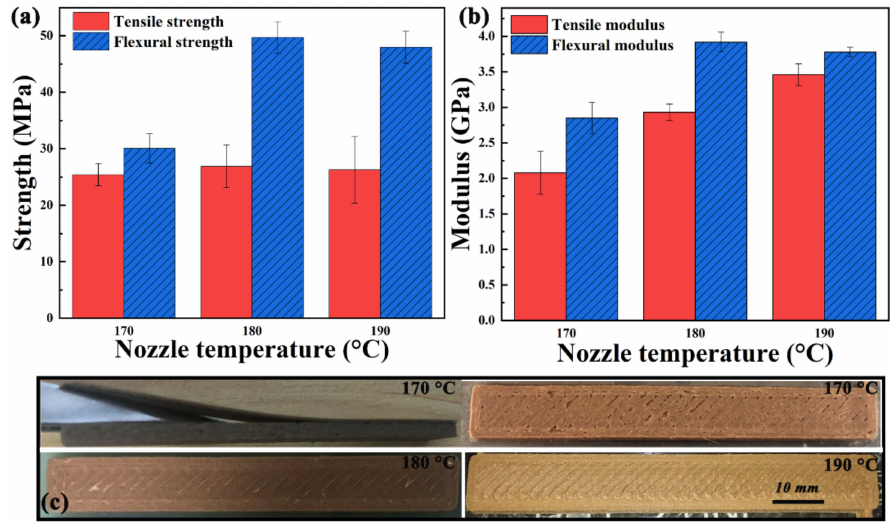
Figure 11. ( a ) Mechanical strength and ( b ) modulus, and ( c ) surface quality of samples printed at various nozzle temperatures.